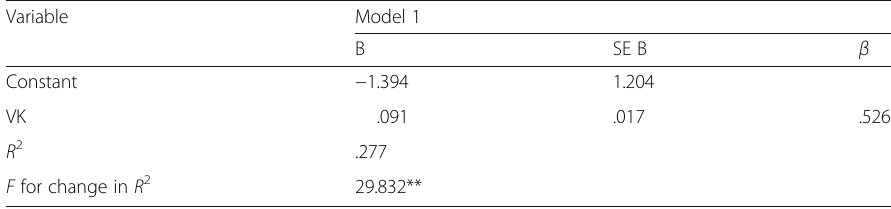
Table 8 Summary of the stepwise regression analysis for the MC test